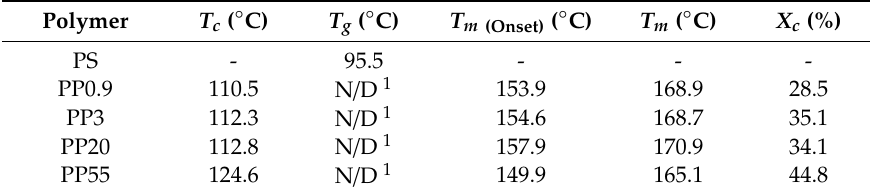
and ( b ) DSC thermograms showing the melting behavior. Table 4. Thermal characteristics for neat PPs and PS polymers.